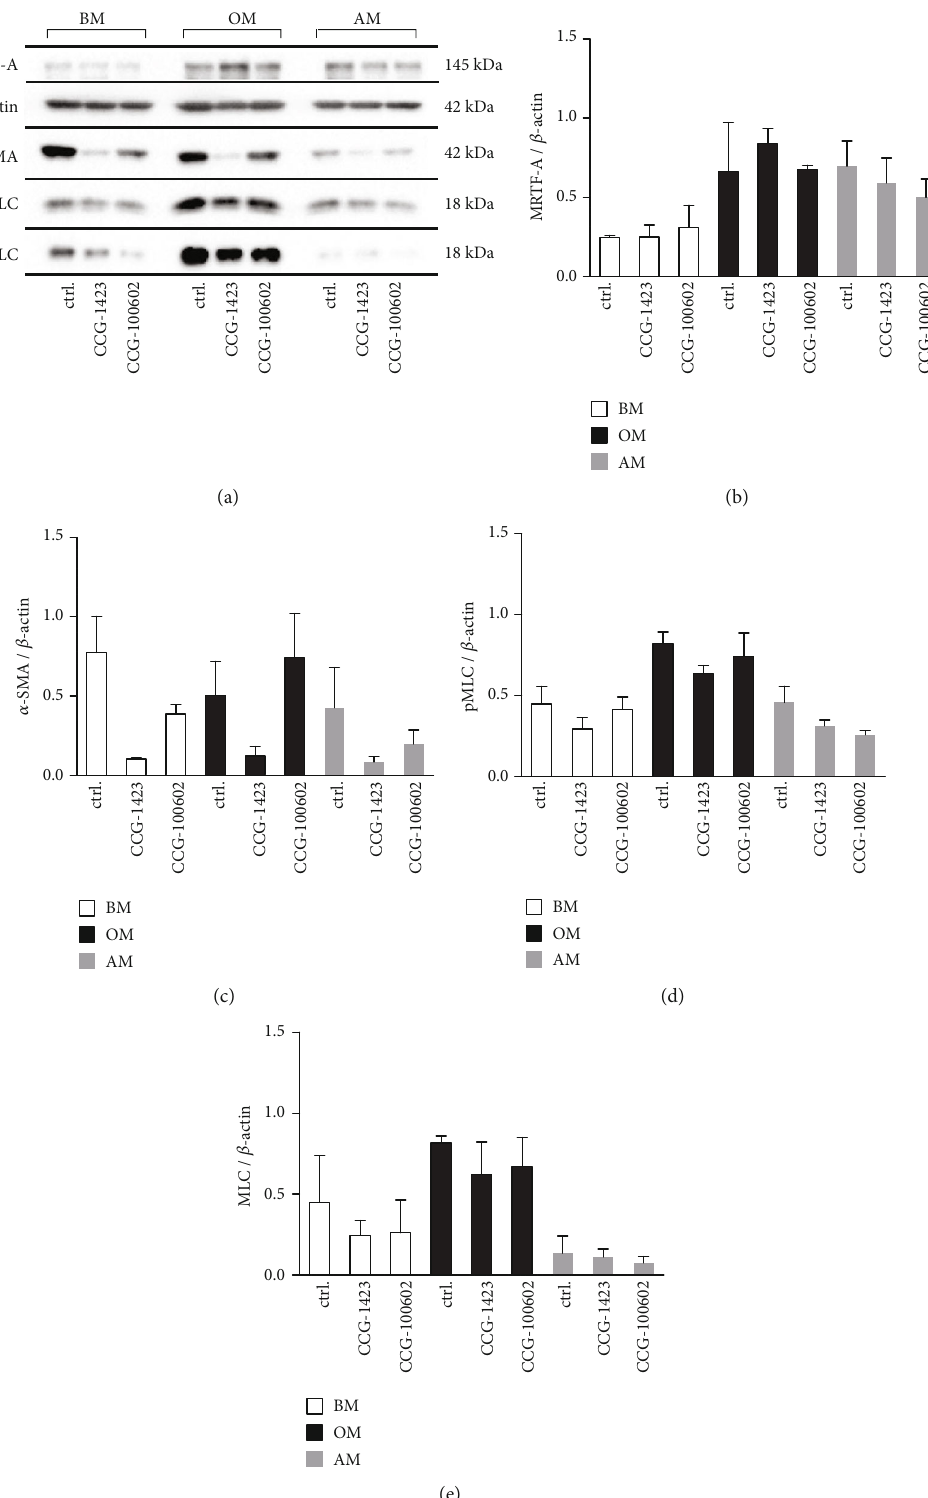
Figure 5: Intracellular protein levels of MRTF-A, β -actin, α -SMA, pMLC, and MLC as a response to MRTF-A inhibition. hASCs were cultured 7d in BM, OM, or AM media supplemented with 20 μ M CCG-1423 or 12 μ M CCG-100602. (a) Representative WB results of immunoblotted MRTF-A, β -actin, α -SMA, pMLC, and MLC. Semiquantitative results of MRTF-A (b), α -SMA (c), pMLC (d), and MLC (e) normalized with β -actin. MRTF-A and α -SMA: N = 2 independent experiments, 2 donors; pMLC and MLC: N = 4 independent experiments, 2 donors. BM: basic medium; OM: osteogenic medium; AM: adipogenic